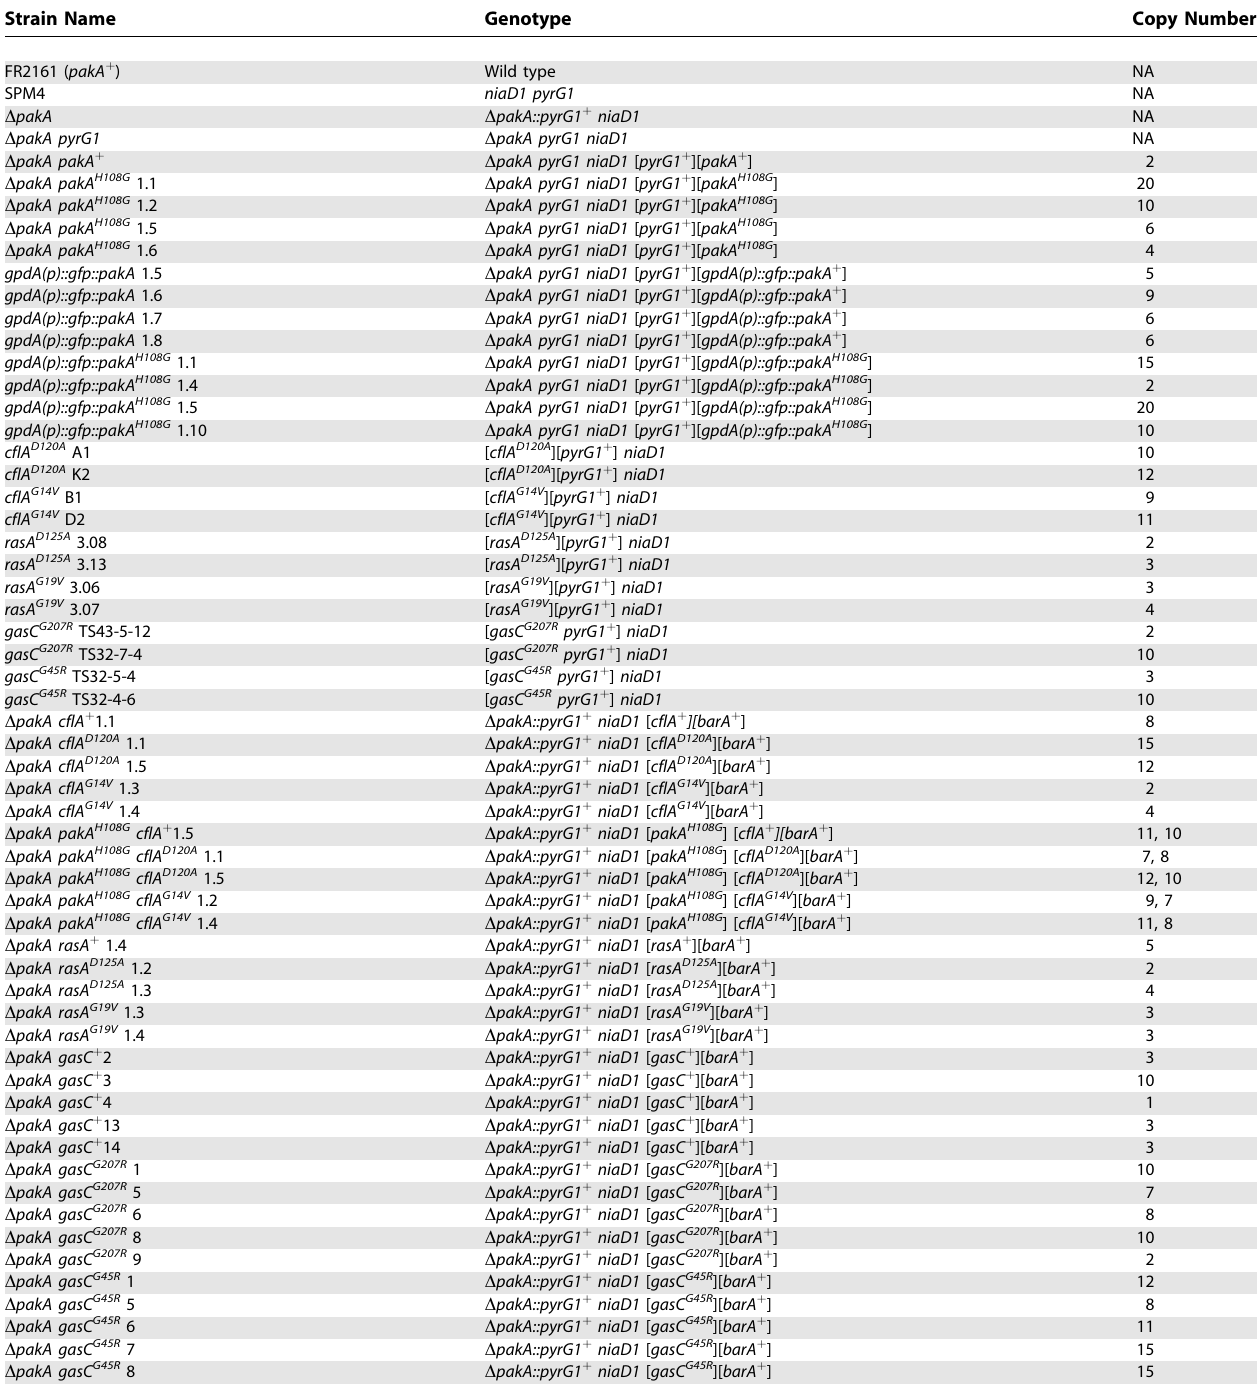
Table 1. P. marneffei Strains Used in This